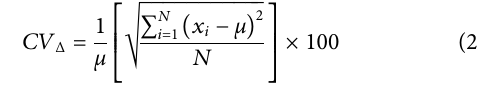
Frontiers in Remote Sensing |